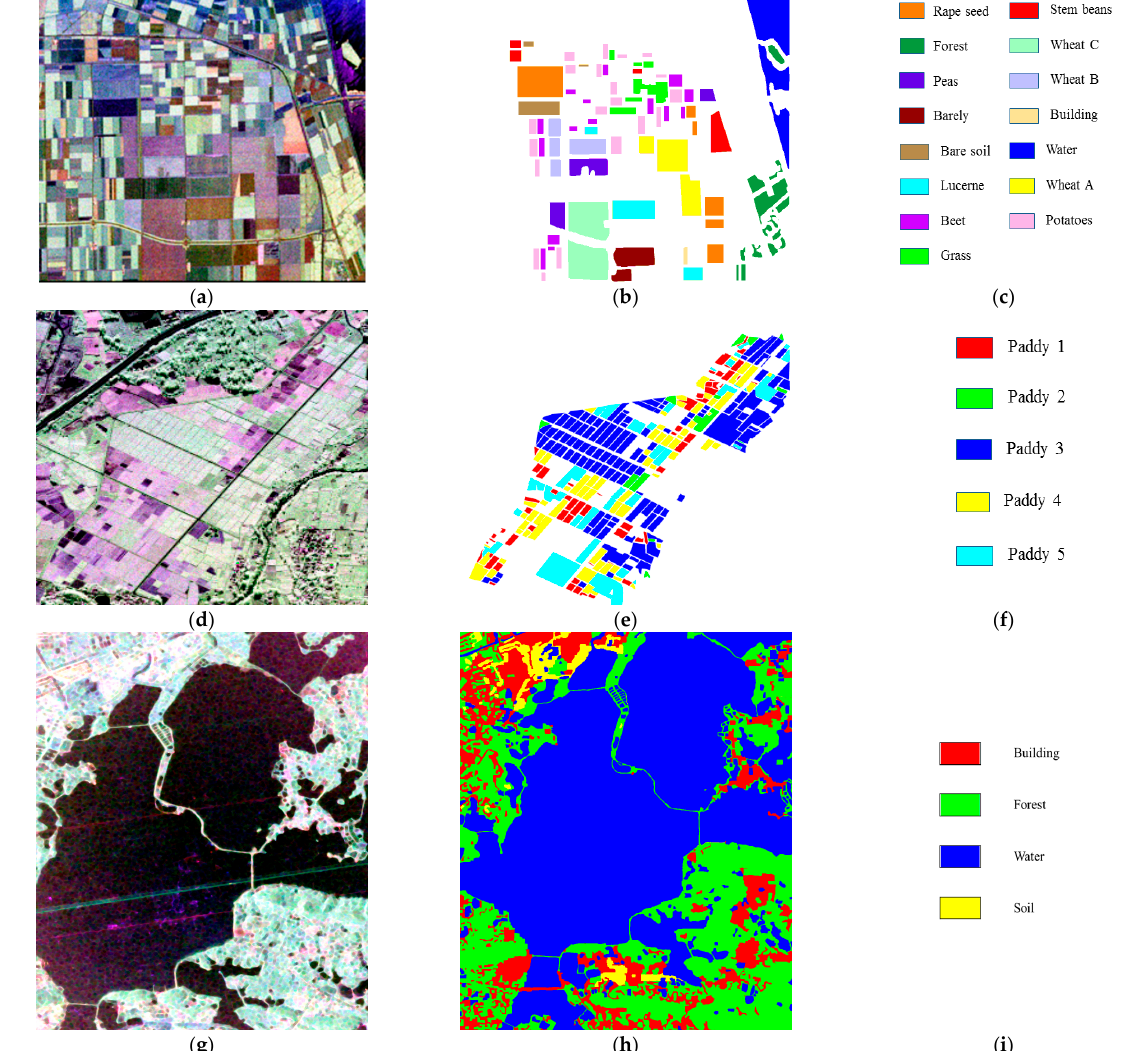
Figure 2. Pauli-RGB images of the three experimental datasets and the ground-truth maps: ( a ) Pauli-RGB of AIRSAR imagery; ( b ) Ground-truth map for the AIRSAR imagery;( c ) Land-cover categories of AIRSAR imagery;( d ) Pauli-RGB of UAVSAR imagery; ( e ) Ground-truth map for the UAVSAR imagery; ( f ) Land-cover categories of UAVSAR imagery; ( g ) Pauli-RGB of RadarSat-2 imagery; ( h ) Ground-truth map for the RadarSat-2 imagery; ( i ) Land-cover categories of RadarSat-2 imagery.